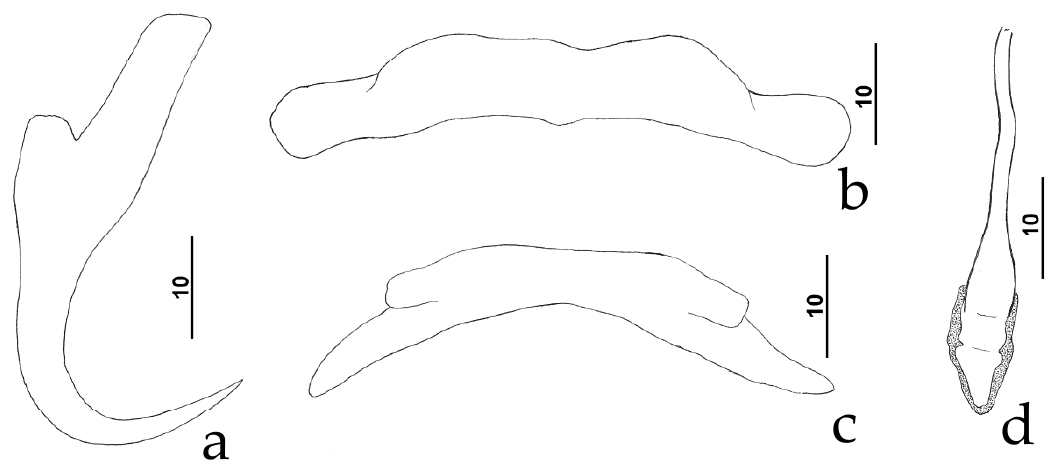
Figure 7. Ancyrocephalus vesiculosus Murray, 1931. ( a ). ventral anchor; ( b ). ventral bar; ( c ). dorsal bar; ( d ). male copulatory organ (ventral